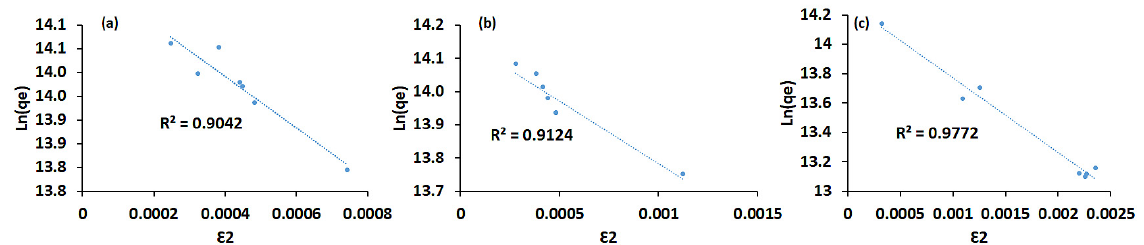
Figure 6. Comparison of the Dubinin–Radushkevich isotherm model of ESCaCO 3 NPs ( a ), RHSiO 2 NPs, ( b ) and CS-SiO 2 /CaCO 3 NCs ( c ), respectively.